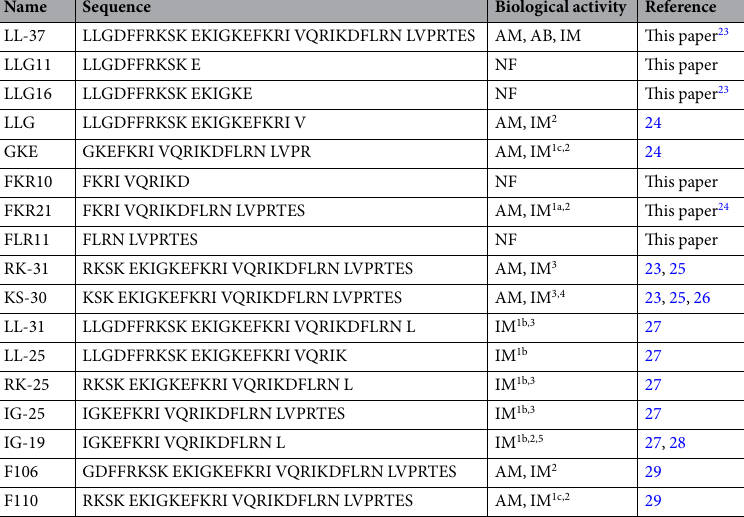
Table 2. A selection of published peptide sequences derived from LL-37 with immune-modulating actions, and examples of their biological effects. IM, immune-modulatory effects: 1a Reduced LPS or LTA induced NF- κΒ and AP-1 activation or 1b LPS binding, with implication to neutralize the LPS cytokine response, 1c Inhibition of LPS-induced nitric oxide production, 2 chemotactic activities on human neutrophils, 3 inhibition of IL-8 production, 4 increased IFNs production from keratinocytes, 5 abrogated IL-32 γ induced TNF- α and IL-1 β production in peripheral blood mononuclear cells (PBMC). AM, antimicrobial effects. AB, anti-biofilm effects. NF, no immune-modulating activity found. F,